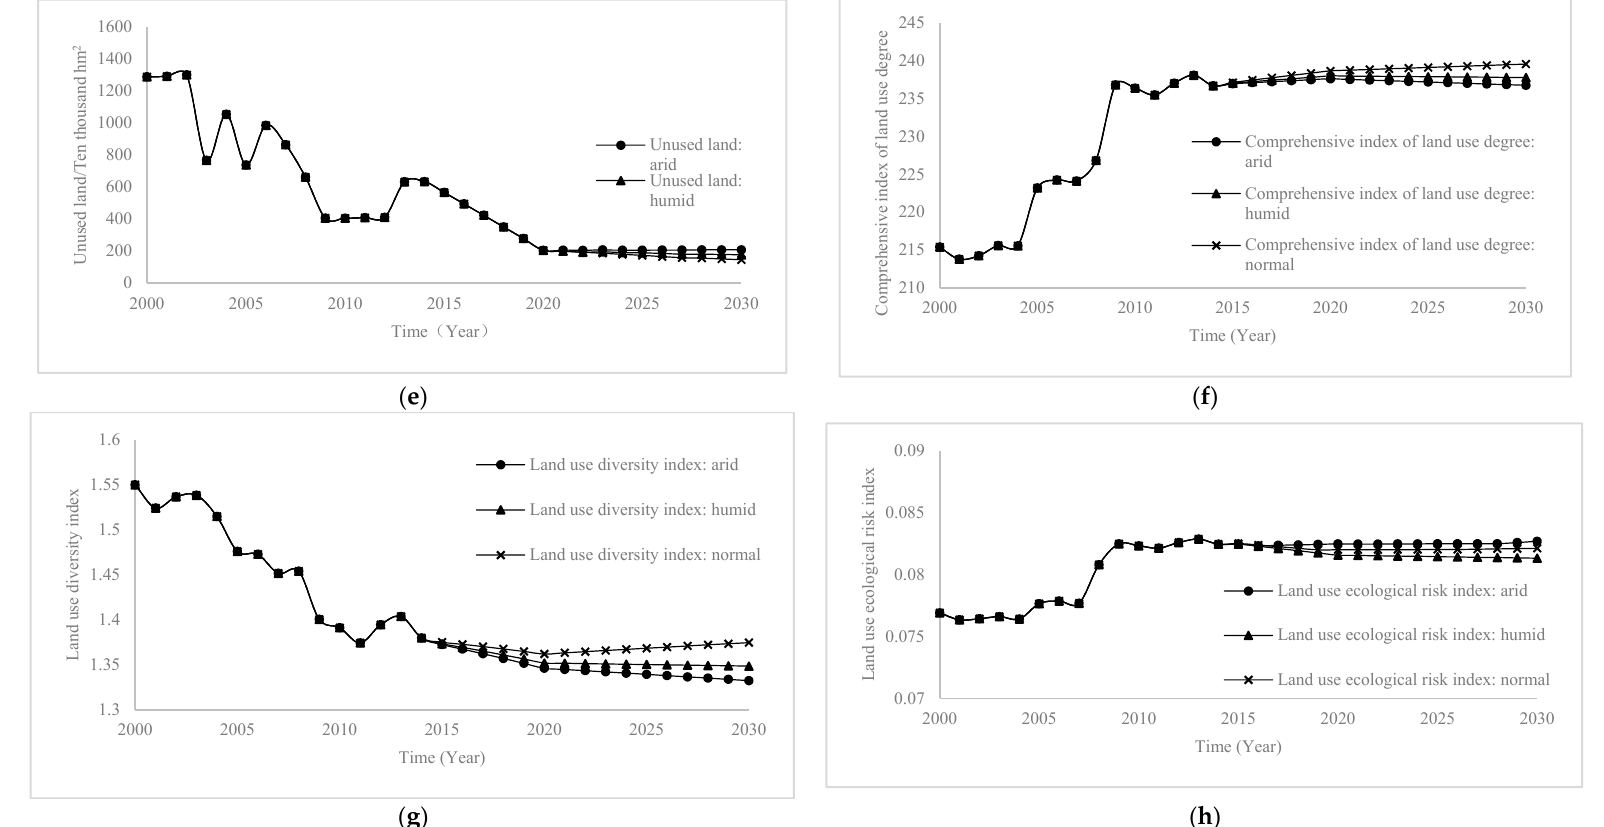
Figure 7. Simulation of land and water resource system dynamics model of Heilongjiang Province under different climate conditions. ( a ) Water supply-demand ratio; ( b ) Water use efficiency index; ( c ) Water shortage risk index; ( d ) Coefficient of agricultural land and water resource matching; ( e ) Unused land/Ten thousand hm 2 ; ( f ) Comprehensive index of land use degree; ( g ) Land use diversity index; ( h ) Land use ecological risk index.